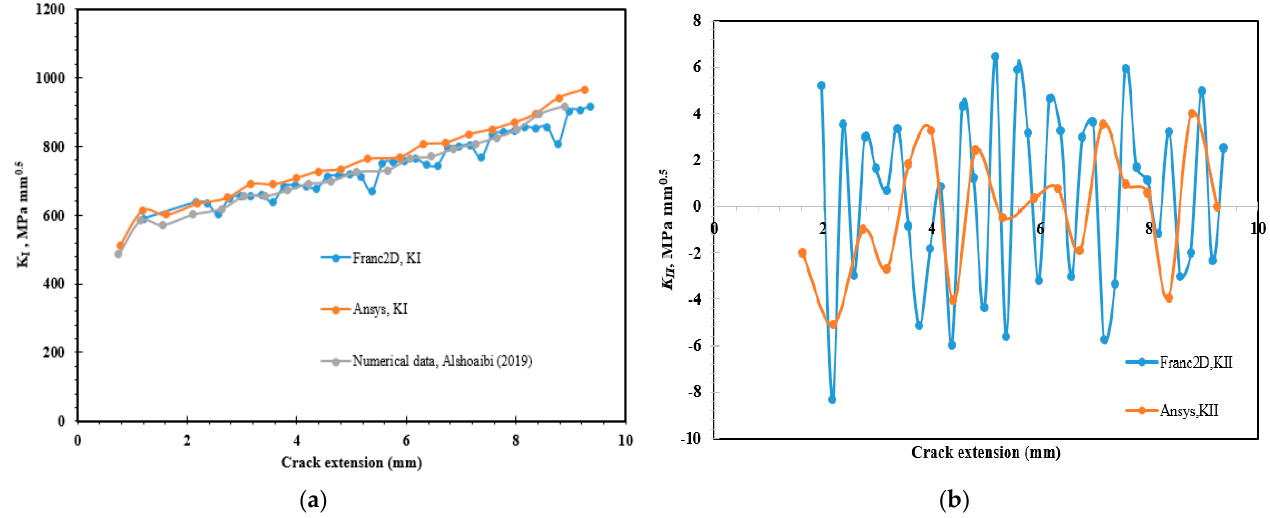
Figure 15. Stress intensity factors with corresponding crack length for specimen G6, ( a ) K I, and ( b ) K II .